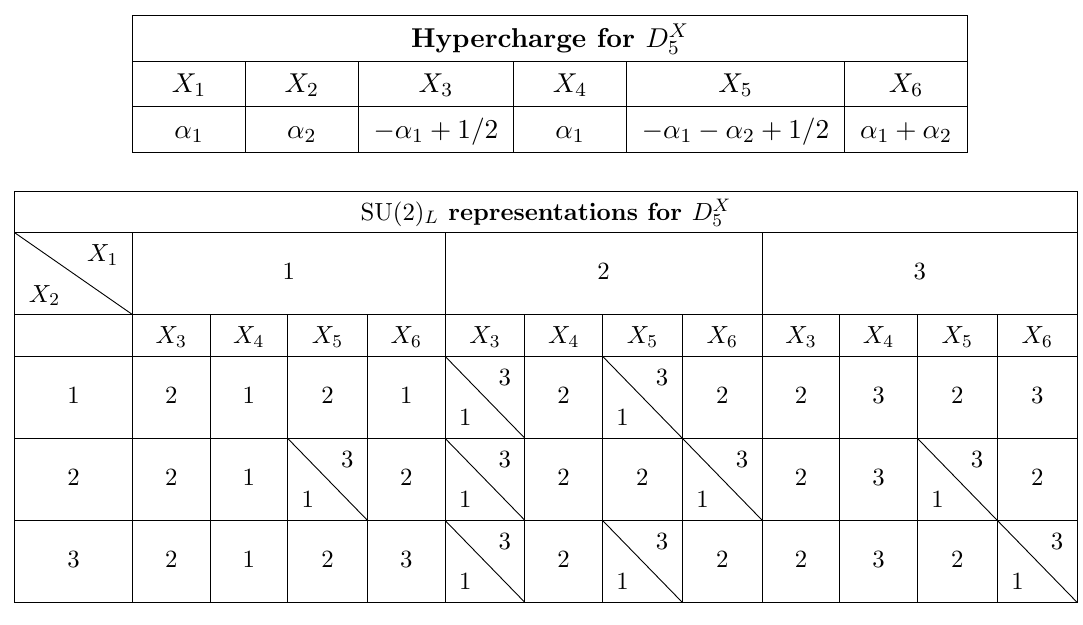
Table 5 . Standard Model quantum numbers for the diagram D X We follow tables 1 and 4 with two input (cid:12)elds X 1 and X 2 with general hypercharges and SU(2) L representations up to triplets. All the (cid:12)elds are colour